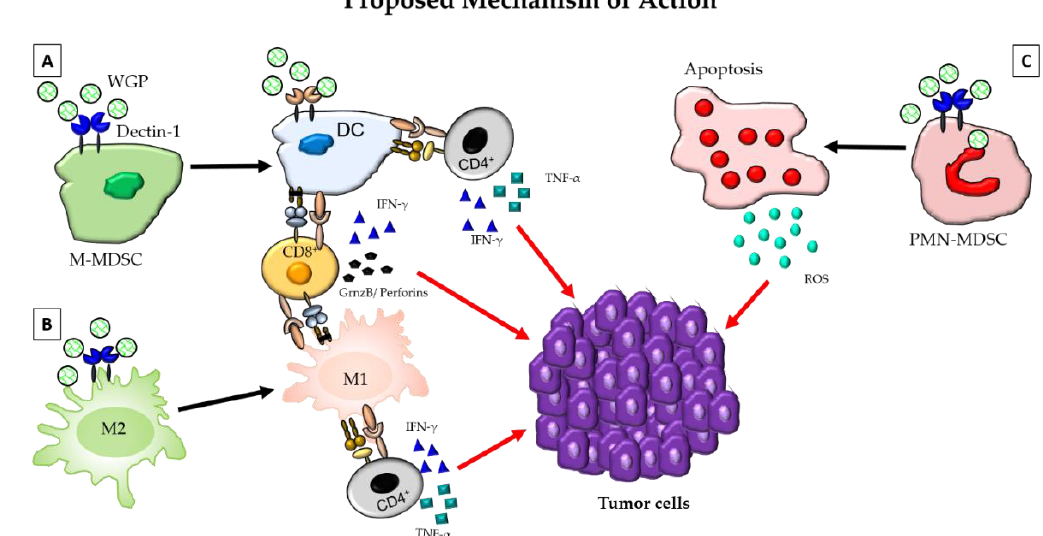
Figure 1. The modulation of the immune cells in the tumor microenvironment by β -glucan. β -glucan binds to the Dectin-1 receptors expressed on cells of the myeloid lineage, and will then be phagocytosed. In 1a, β -glucan can be seen binding to Dectin-1 on an M-MDSC. Binding to the M-MDSC will cause the M-MDSC to switch from a suppressive phenotype, to a DC phenotype that can act as an APC. This dendritic cell (DC) will then activate CD4 + and CD8 + T-cells, where CD4 + T-cells will secrete pro-inflammatory cytokines, such as TNF α and IFN- γ , and CD8 + T-cells will secrete Granzyme B, perforins and IFN- γ . The secretion of these pro-inflammatory cytokines by CD4 + and CD8 + T-cells will lead to the destruction of tumor cells. Similar to 1a, in 1b, β -glucan induces the polarization of suppressive M2 macrophages into inflammatory M1 macrophages. M1 macrophages will then activate Th1 type T-cells, leading to damage to the tumor cells through the secretion of pro-inflammatory cytokines by CD4 + and CD8 + T-cells. Finally, in 1c, β -glucan will bind to the Dectin-1 receptor on polymorphonuclear (PMN)-MDSCs and cause apoptosis of the cell. As the cell undergoes apoptosis, it will produce ROS that will ultimately target the tumor cells, leading to tumor cell death.